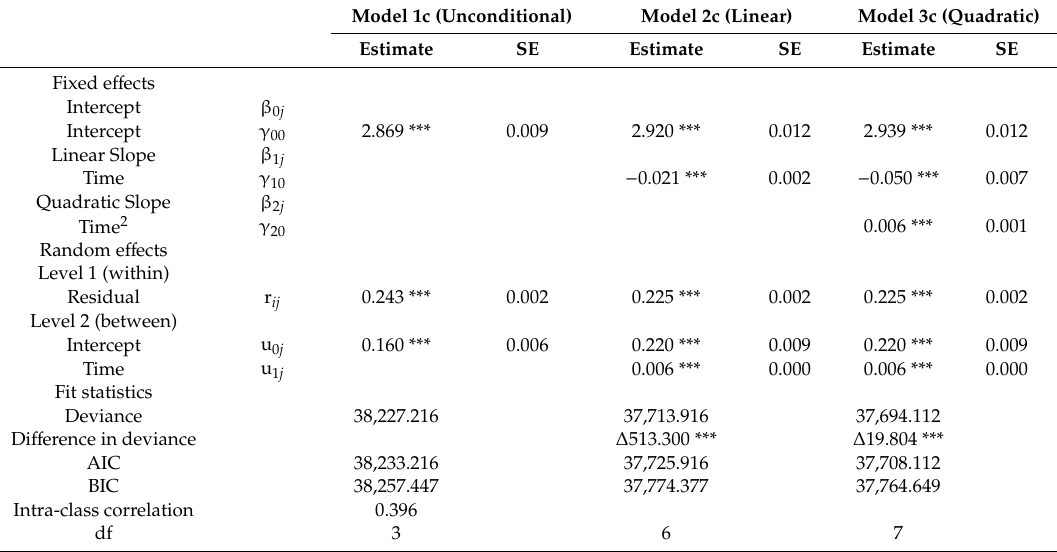
Table 5. Results of IGC models for parent-child relational quality (Wave